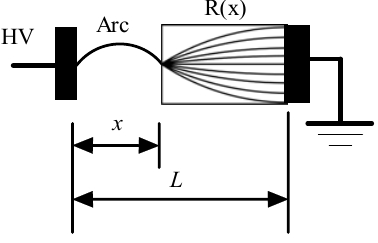
Figure 3. Residual resistance calculation model of a single